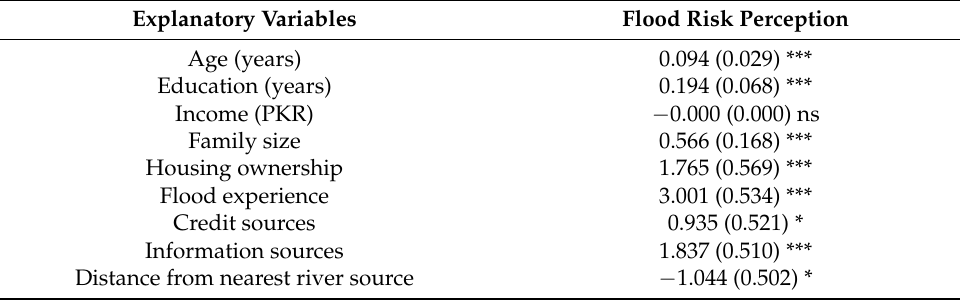
Table 4. Important attributes that could influence households flood risk